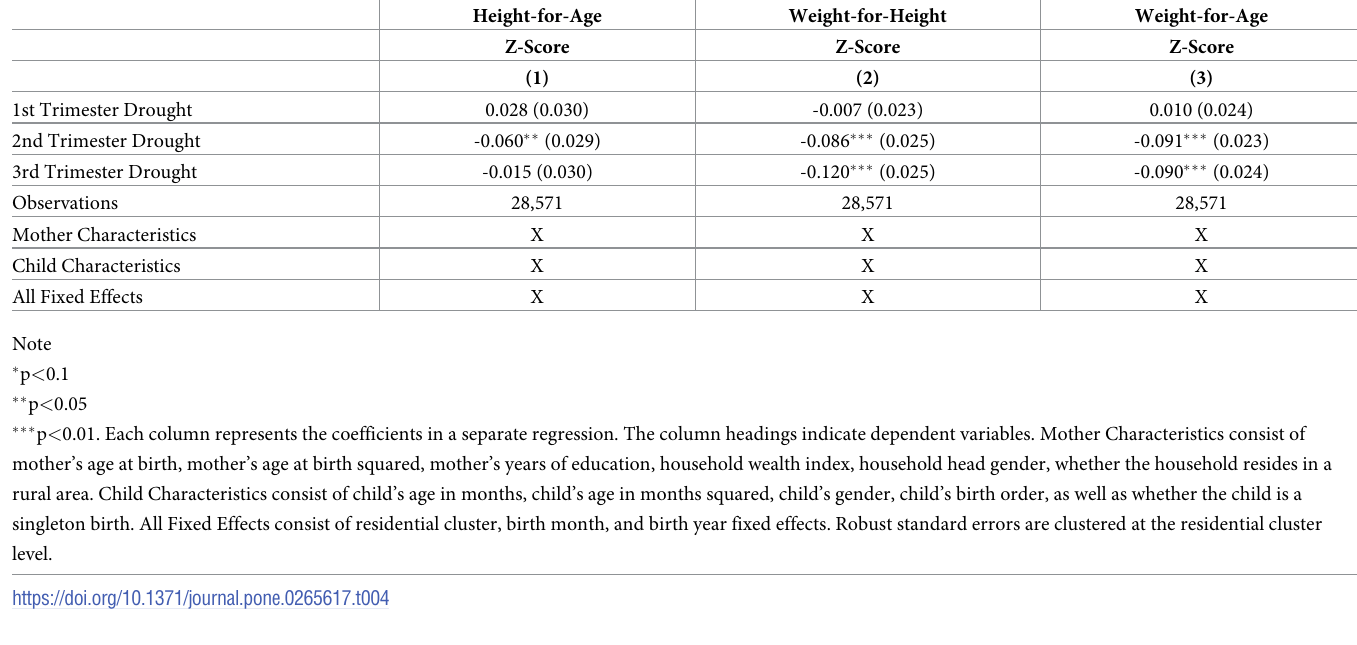
Table 4. Prenatal exposure to droughts and child health—Trimester analysis. Height-for-Age